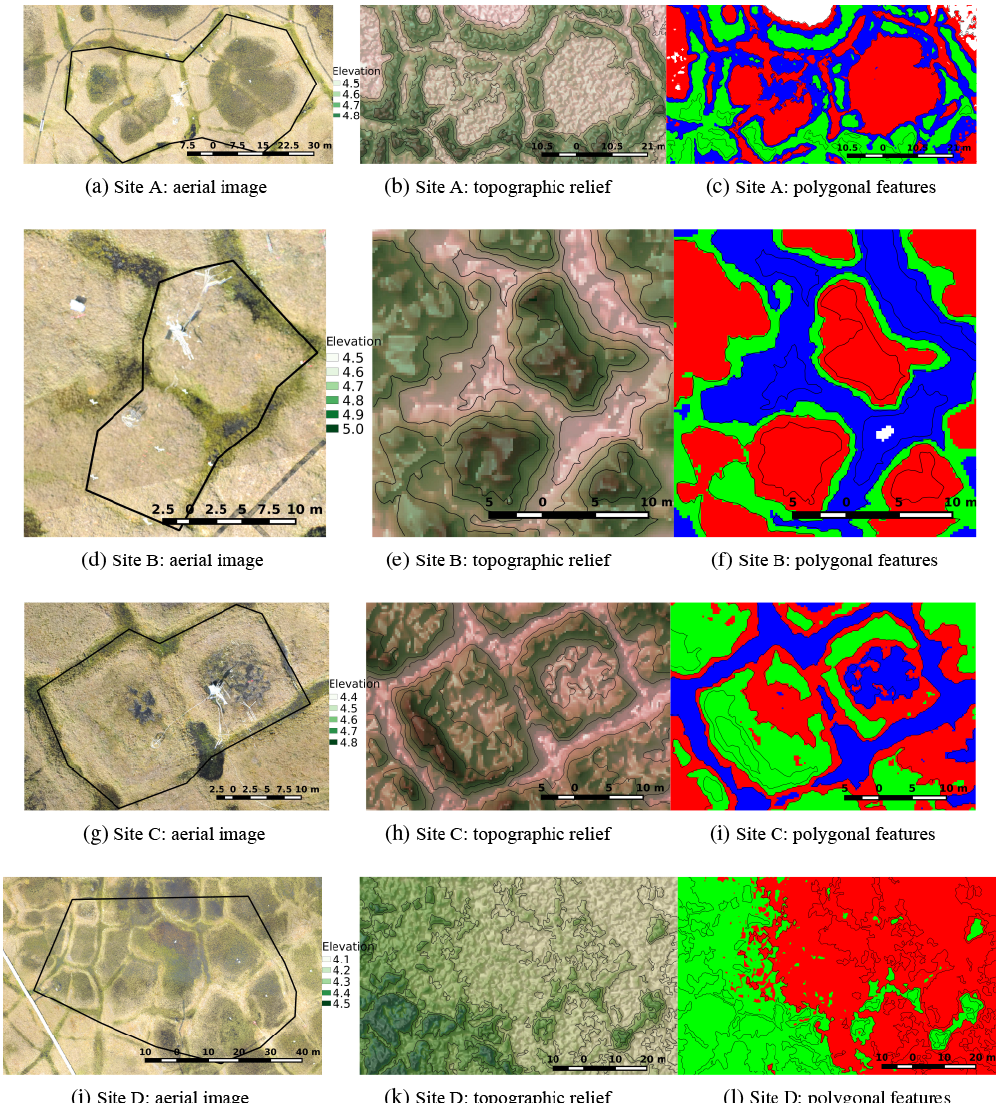
Figure 2. Elevation contour-based classification of the study areas at Sites A, B, C and D. In subfigures (c, f, i, l) the colors reflect polygon type (red: center; green: ridge; blue: